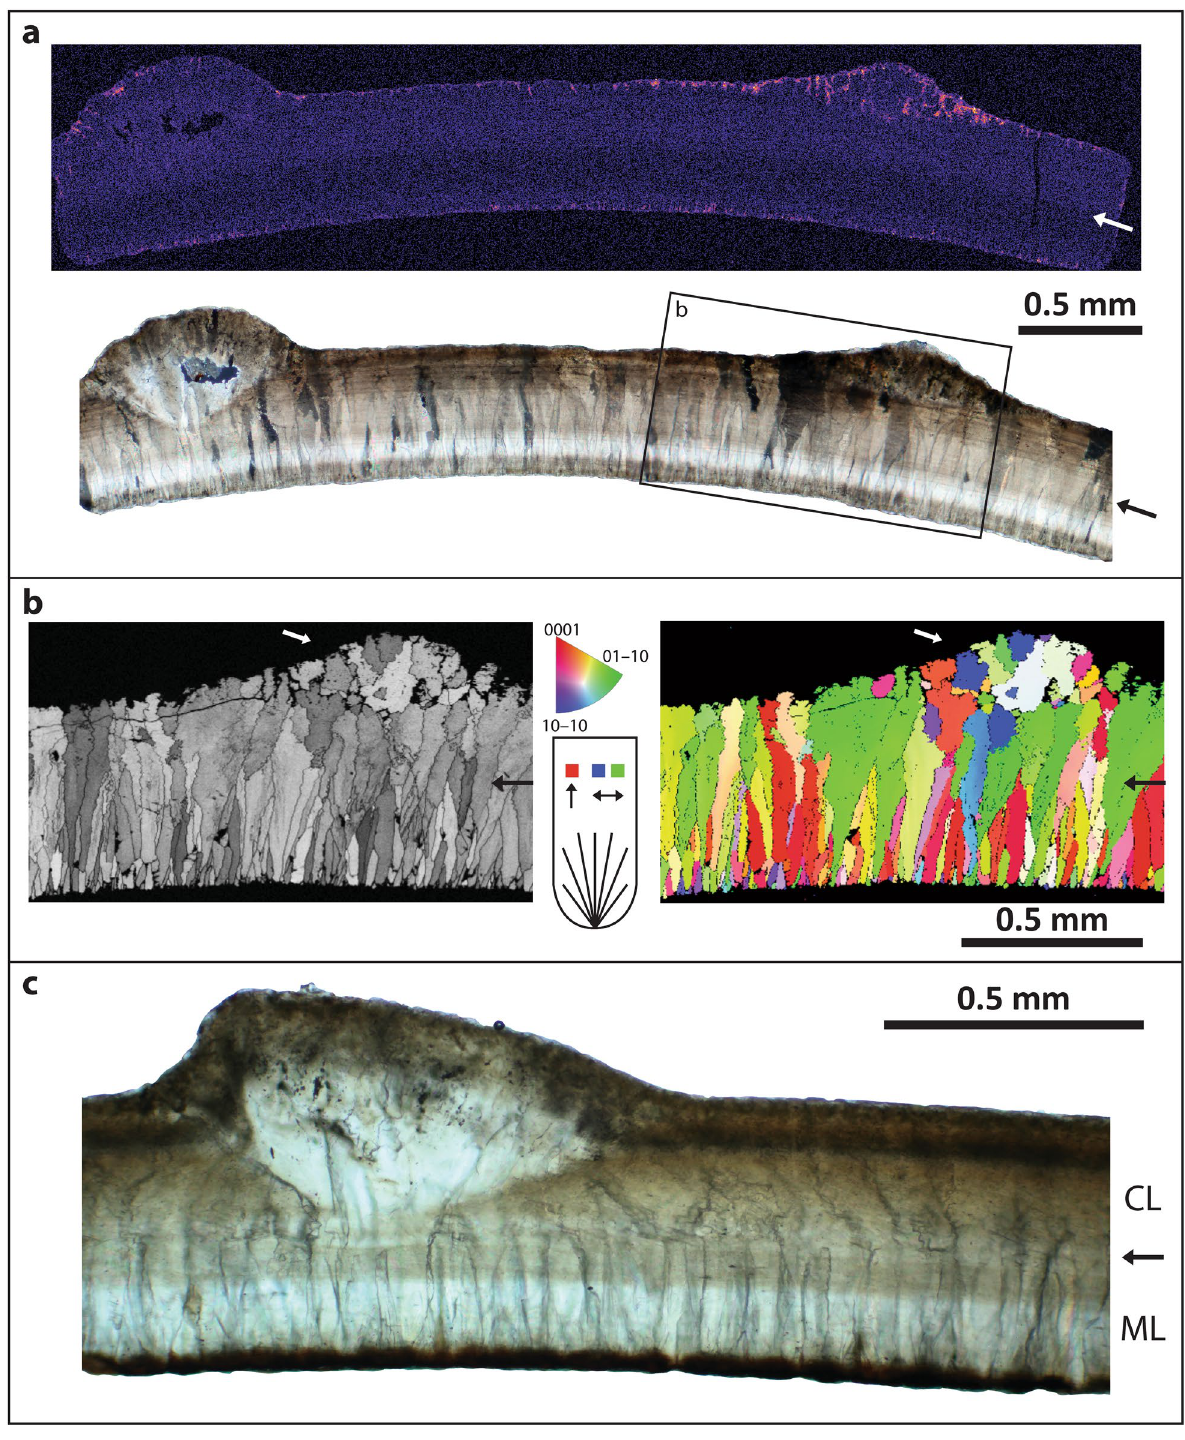
Figure 4. Stillatuberoolithus storrsi oogen. et oosp. nov. UCM 1139 (paratype). ( a ) EMPA elemental mapping of magnesium (Mg) through a thin section of eggshell (pictured beneath in cross-polarized light). Colour scale ranges from high (bright magenta) to low (dark magenta) concentration. Lowest concentration is in the mid-upper mammillary layer, with upper boundary distinctly visible (arrow). Pseudocolour was applied to the original grey scale image with Fire LUT in Image J (https:// imagej. nih. gov/ ij/), and adjustments were applied to the whole image ; ( b ) EBSD band contrast map (left) and IPF Y crystallographic orientation map (right) showing mammillary-continuous layer transition (black arrow) with rugged grain boundaries in the continuous layer. Note the node (white arrow) is crystallographically discontinuous from the underlying eggshell. Key indicates calcite crystal c-axis orientation; ( c ) Radial thin section in plane light displaying the boundary between the mammillary and continuous layers (arrow). Note rugged grain boundaries in the continuous